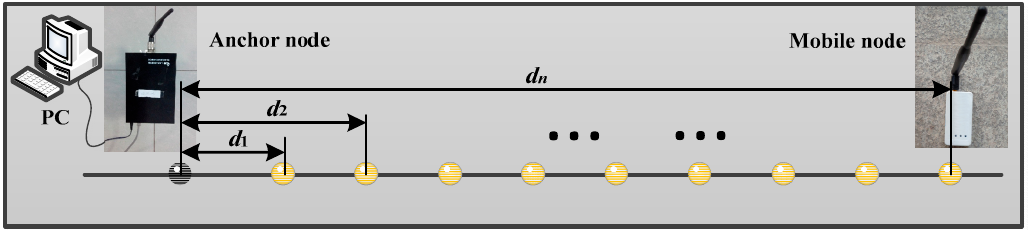
Figure 2. Experimental platform for the measured distance of WSN.